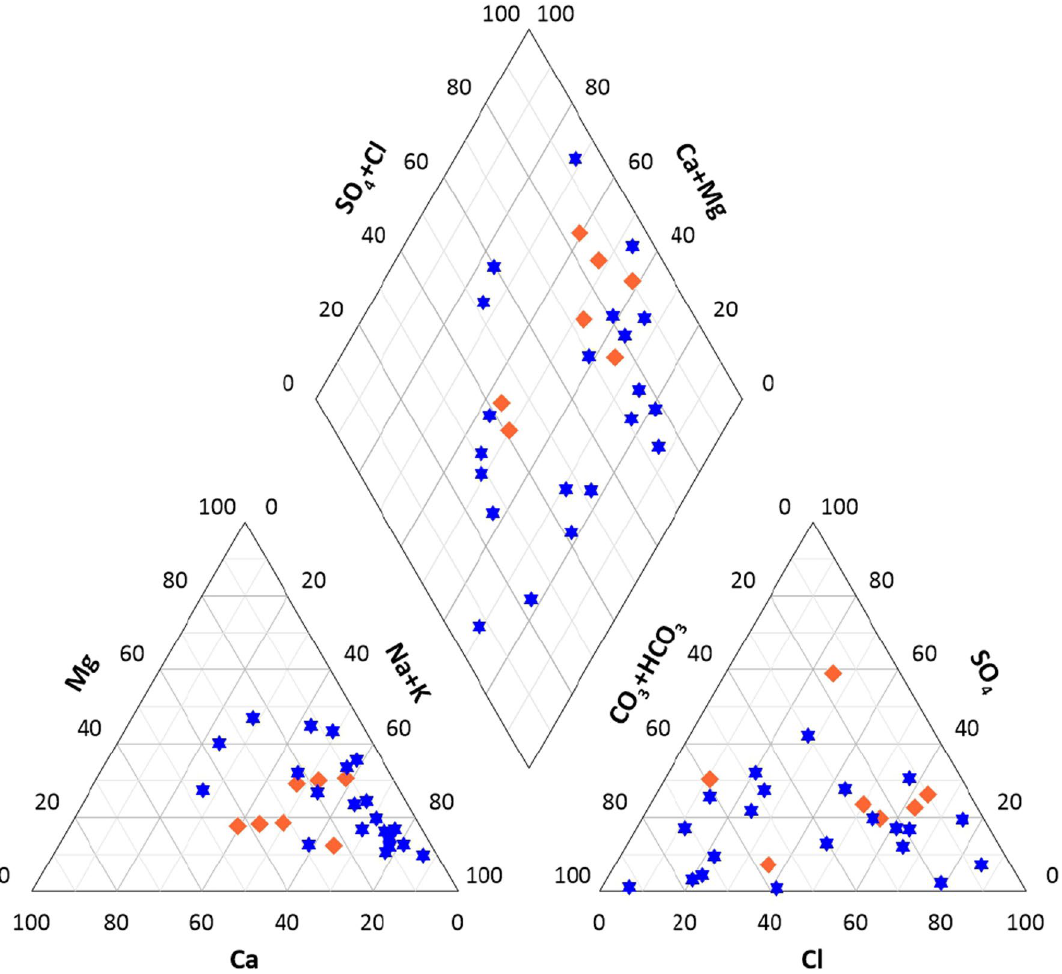
Fig. 2 Piper plot showing the concentration of geochemical parameters of groundwater over the study area (the orange-colored quadrilateral- shaped and blue-colored star-shaped marks represent the sites from Faridabad and Gurgaon districts,